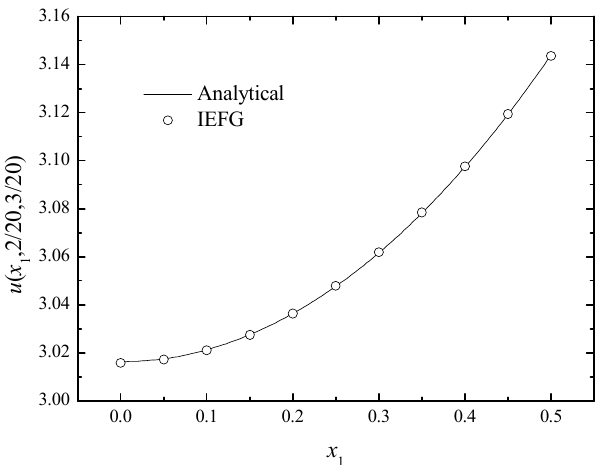
Figure 7. The comparison of numerical and exact solutions along x 1 -axis.